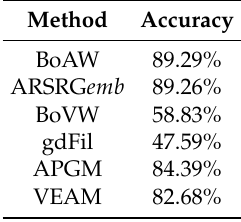
Table 13. Results on the ETH-80